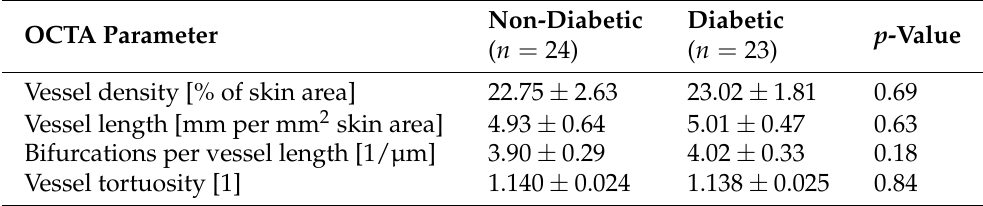
Table 2. OCTA vessel parameters at baseline before induction of the dermal wound on the mouse pinna (mean ± standard